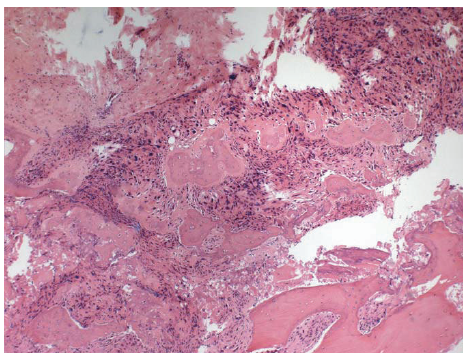
Figure 3: Biopsy of proximal femoral lesion showing high-grade intramedullary osteosarcoma.